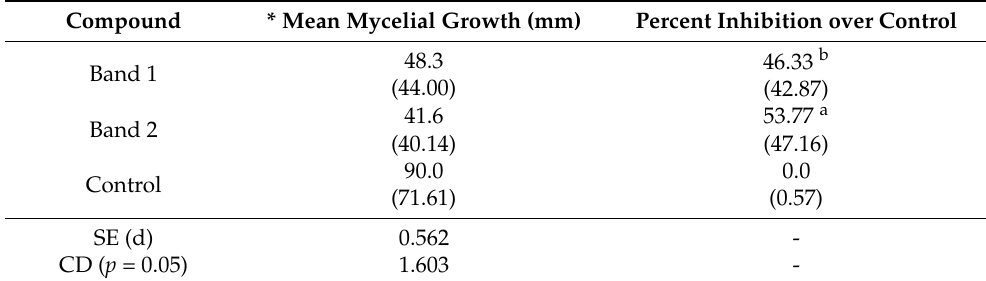
Table 2. Testing the antimicrobial activity of compounds eluted from TLC band of G. lucidum (extracts from fruiting body) against mycelial growth of C. gloeosporioides